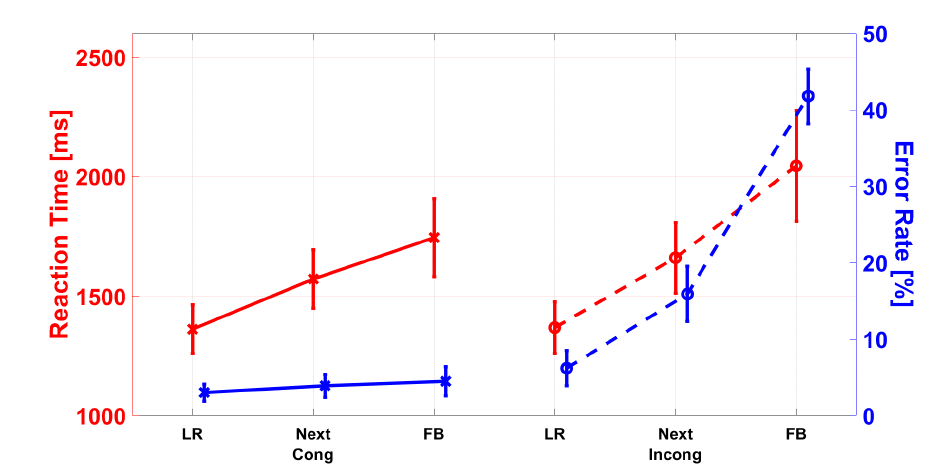
Figure 7. Difference in reaction times (RT, red in ms) and error rates (ER, blue in %) between congruent (cong) and incongruent (incong) stimuli for the target–distractor position combination (TD-PC). In the reaction times, the ANOVA revealed an interaction effect, indicating lower RTs in congruent than incongruent trials for next-to and FB conditions. In the error rates, significantly lower ERs were found for congruent than incongruent trials in LR, next-to, and FB conditions. The error bars represent the standard